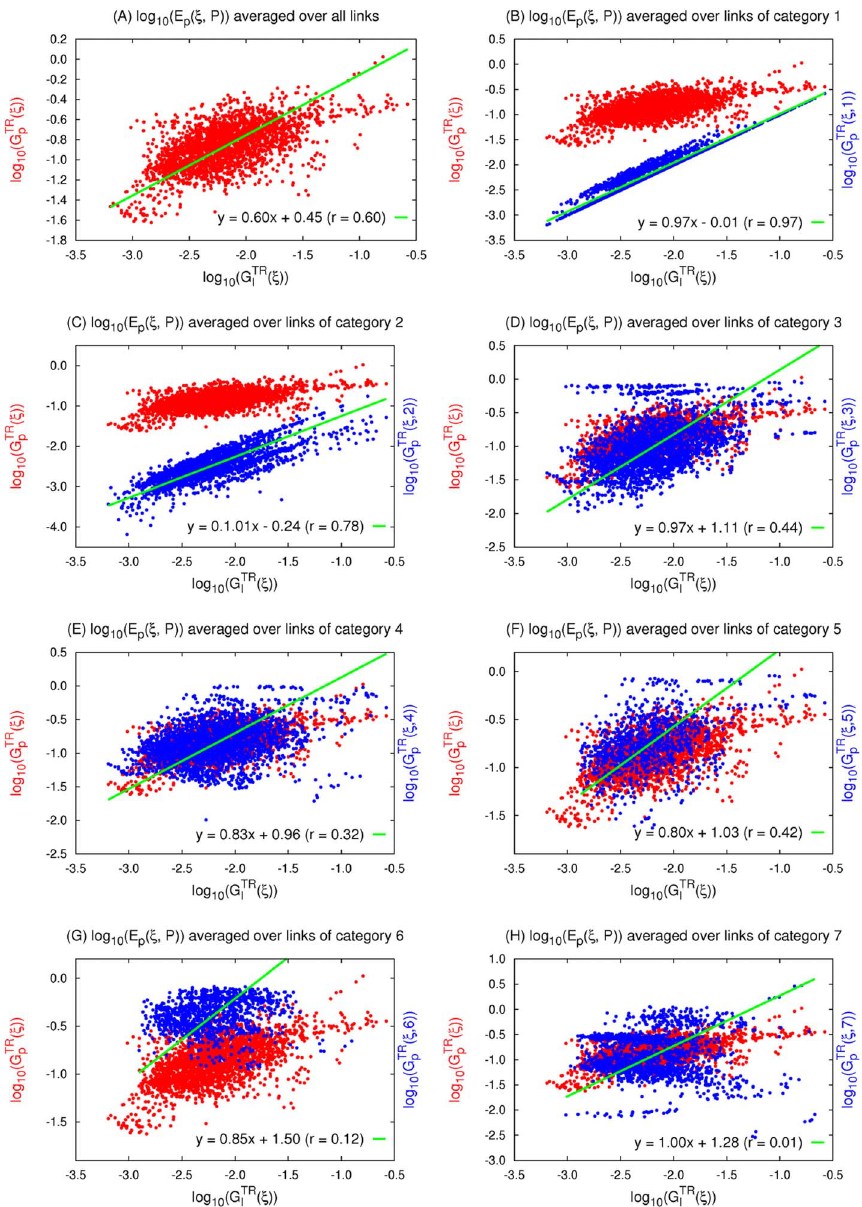
Figures 8. Correlation between robustness to input and parameter perturbations of different categories within 3-node TR j , j ð Þ networks. log 10 G P p